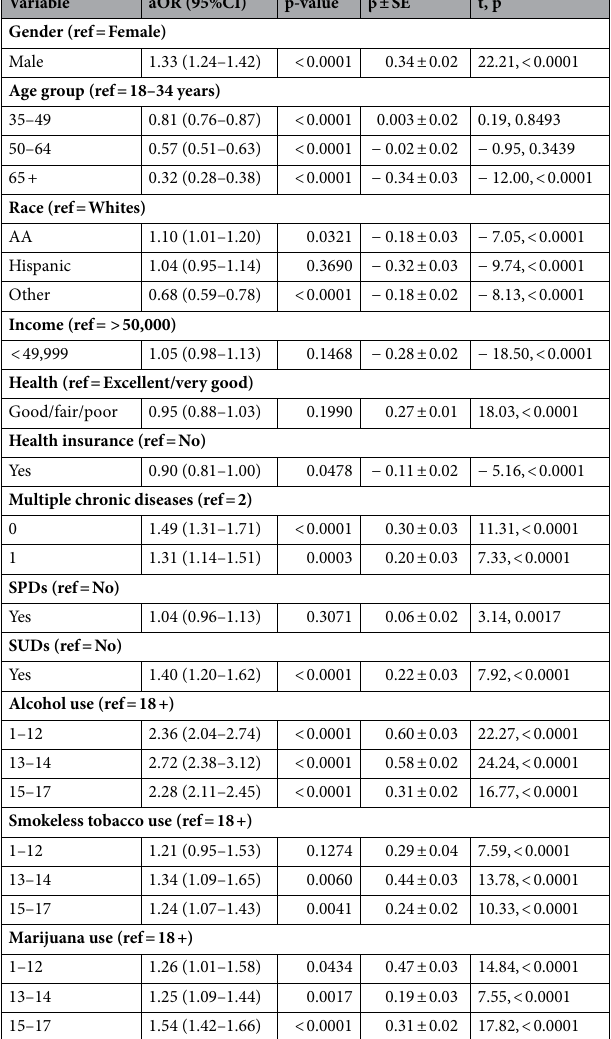
Table 2. Multivariable logistic regression with binge drinking as binary and Poisson regression with number of days of binge drinking in the past month as a count variable. ref reference group, AA African